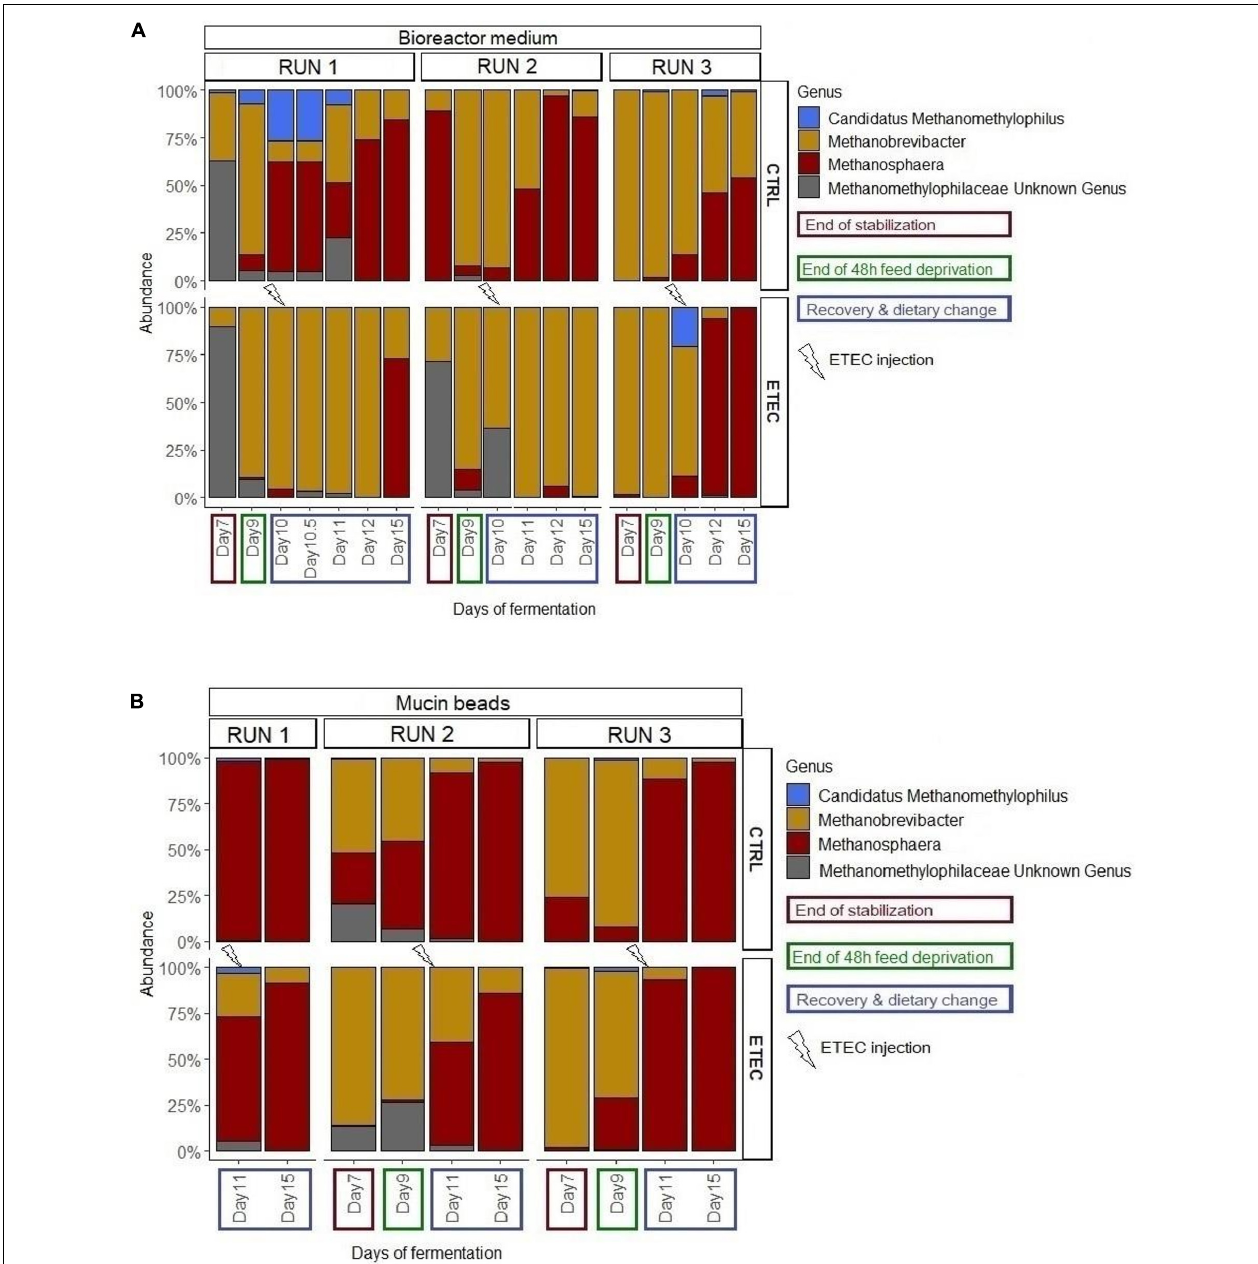
FIGURE 7 | Relative abundance of the archaeal genera in the bioreactor medium (A) and mucin beads (B) of the MPigut-IVM for the runs #1, 2, and 3, in the CTRL and ETEC conditions. Day 7 and 9 of run #1 were removed due to their low number of